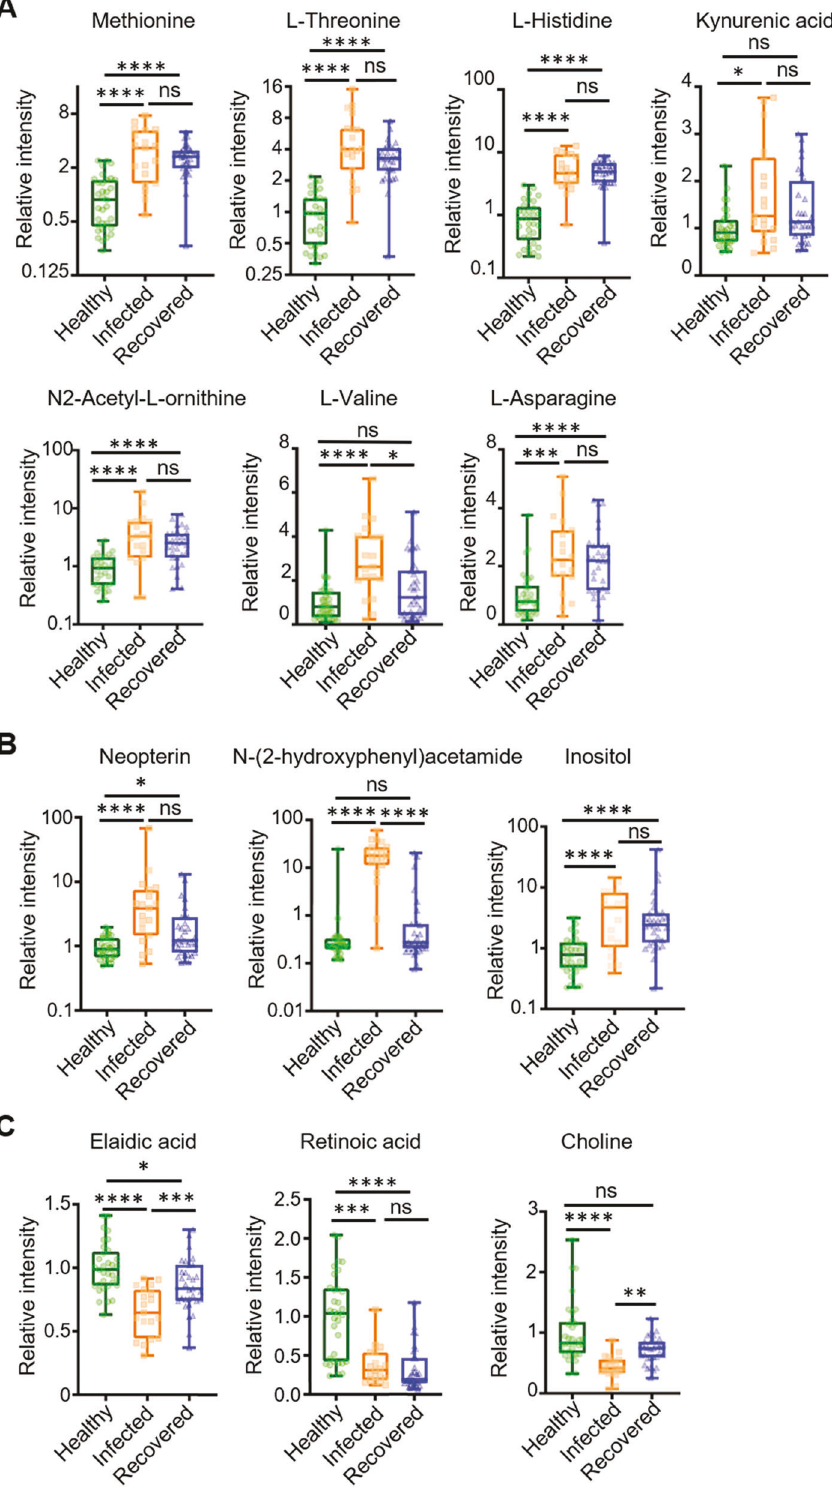
Fig. 3 Differential metabolites between patients with Omicron patients and healthy participants. For the healthy control group, n = 33; for the infected group, n = 19; and for the recovered group, n = 31. ns: nonsigni fi cant. * p < 0.05, ** p < 0.01, *** p < 0.001, **** p <